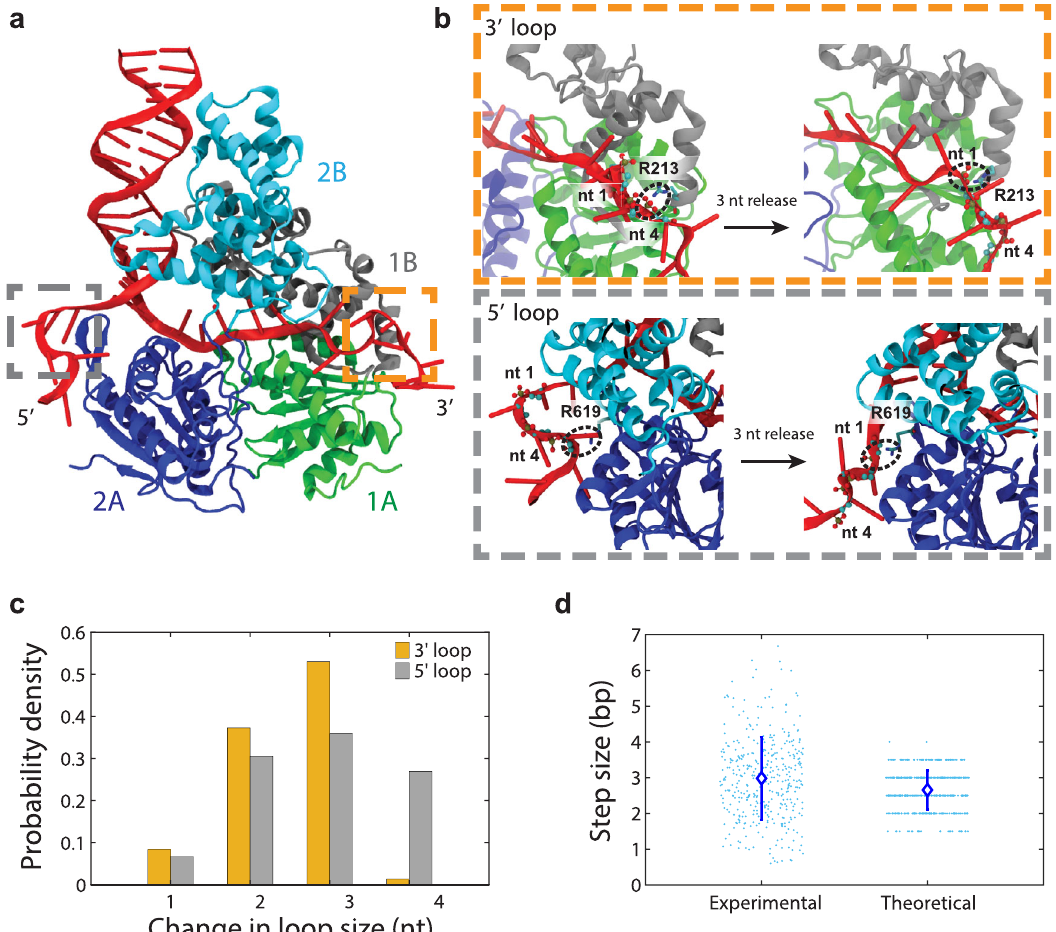
Fig. 3 UvrD sequesters unwound DNA by looping. a Snapshot of MD simulation of UvrD-DNA fork complex showing DNA loop formation. Simulations are based on a crystal structure of UvrD (PDB accession number 2IS2) bound to a ss-dsDNA junction with extended 3 ′ and 5 ′ tails. Both 3 ′ (orange dashed box), and 5 ′ (gray dashed box) loops are shown. b Representative conformations showing how the 3 ′ (orange dashed box) and 5 ′ (gray dashed box) loops are anchored to the protein surface and released. The primary anchor residues for 3 ′ and 5 ′ loops are R213 and R619, respectively. Before the release, nt 4 is in contact with the anchor residue; the 3-nt release is achieved by forming a new contact between nt 1 and the anchor residue. Black dashed circles highlight contact points between the anchor residue and nt 1 or 4. Backbone atoms of DNA phosphate groups and backbone carbon atoms near the contact points are shown in ball-and-stick representation (brown = phosphorous, red = oxygen, cyan = carbon). c Distributions of 3 ′ (orange) and 5 ′ (gray) loop size changes. d Scatter plot comparing the step sizes predicted from simulated loop release to the individual experimental unwinding step size measurements (blue dots) at 0.5 µ M ATP, and plot of average step size for both distributions (blue diamonds). Error bars represent standard deviation. Total number of steps displayed: N = 394 (experimental) and 500 (theoretical). Only integer and half-integer values are possible for the simulated step sizes, as they are calculated from distributions in ( c ), assuming loops released from the 3 ′ and 5 ′ ends are independent. Source data are provided as a Source Data fi